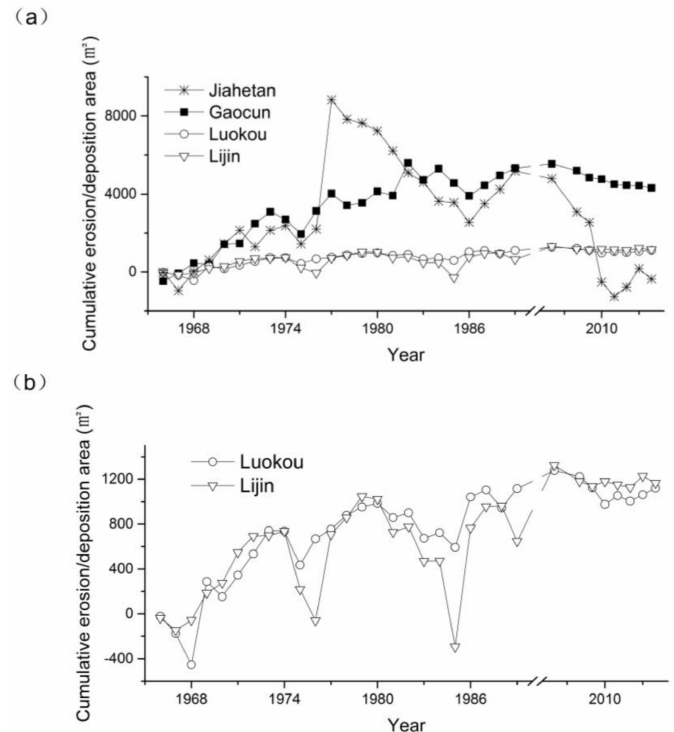
Figure 5. Accumulated erosion/accretion area of ( a ) Jiahetan, Gaocun, Luokou and Lijin; ( b ) Luokou and Lijinin sections the lower Yellow